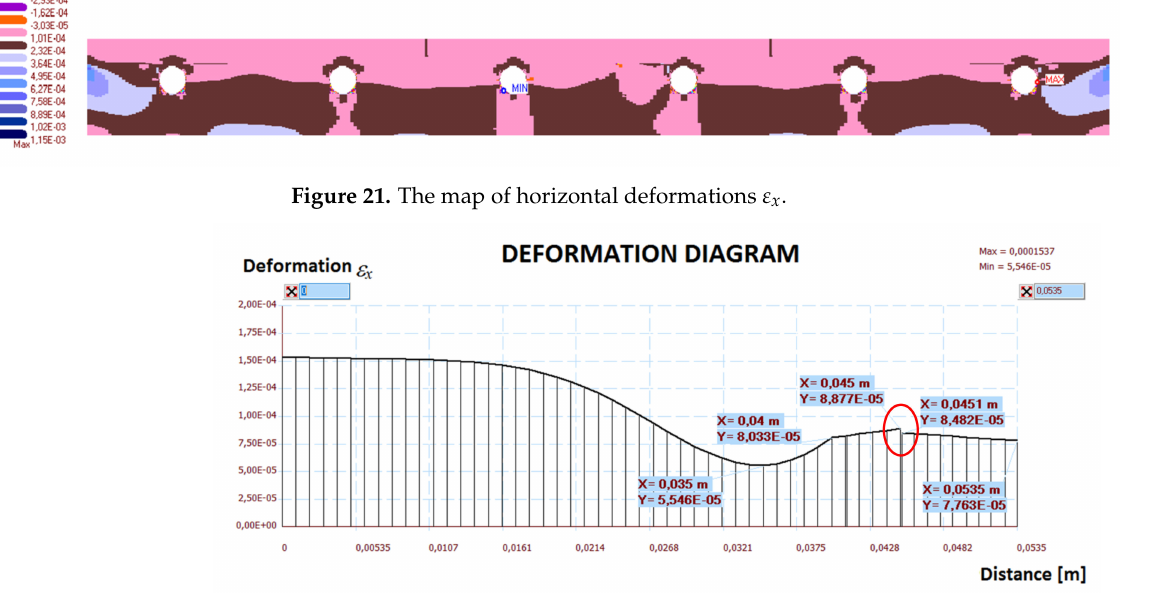
Figure 22. The diagram of horizontal deformations ε x in the I–I section.